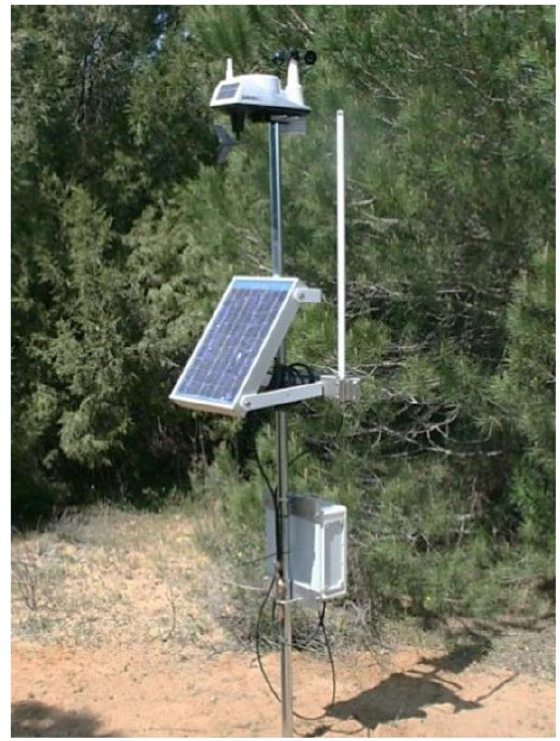
Figure 2. Typical terminal node.